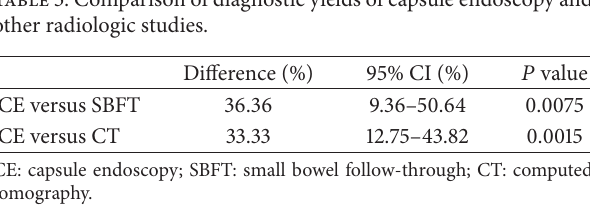
Figure 1: Various indications of diagnostic tests for small bowel tumors.